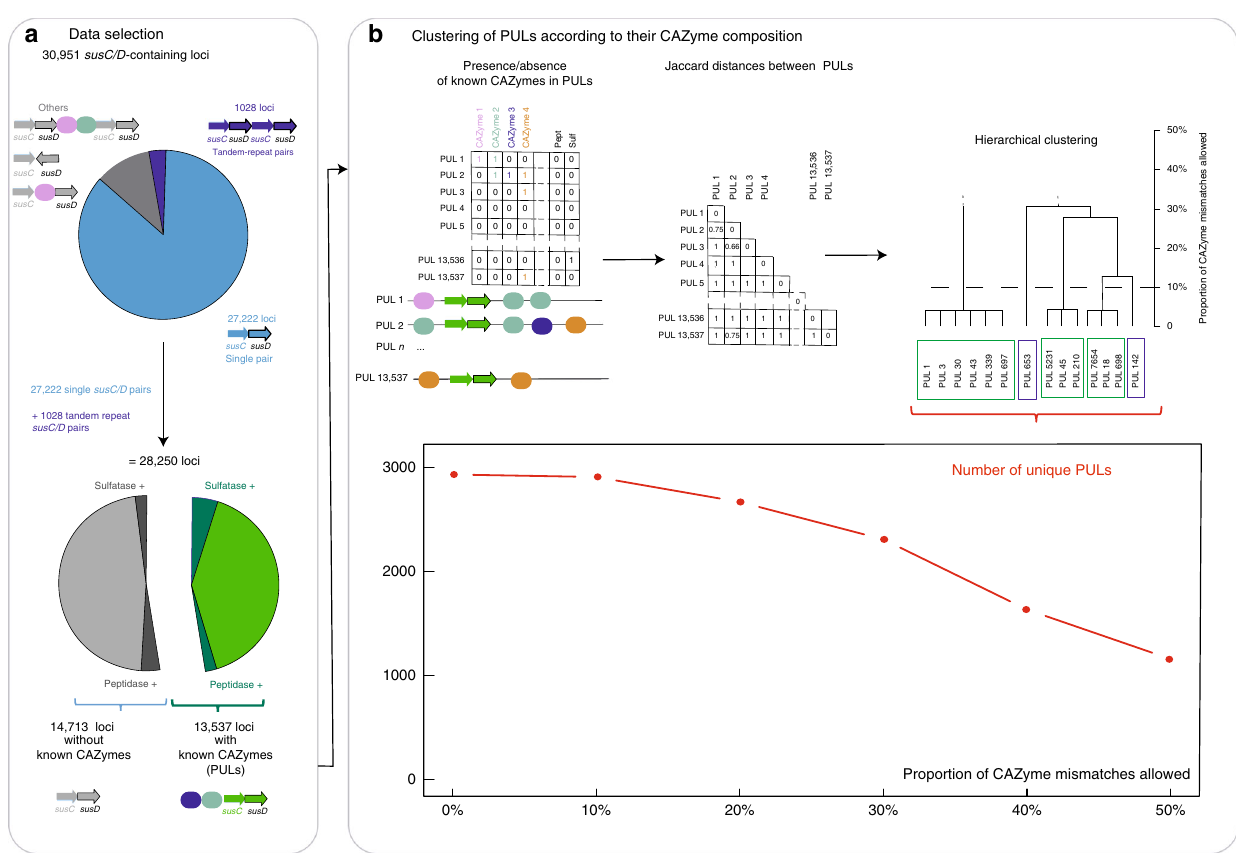
Fig. 2 The PUL analysis pipeline. a Selection and sorting of data from PULDB. b Clustering of PULs according to their CAZyme composition. The distance between each pairs of PULs has been calculated according to the composition in enzyme (sub)families. Hierarchical clustering with different distance thresholds (from 0 to 50% mismatch in CAZyme composition) yields a number of unique PULs between ~1200 and outside PULs) in the 964 genomes (Supplementary Note 1), but intergenic distances did not explain the inter-class variability. We fi rst sorted the 30,951 susC/D- containing loci (this term designates any group of genes around a susC - susD gene pair, with or without CAZymes) listed in PULDB, according to their encoded protein category content (Fig. 2a; Supplementary Data 1).